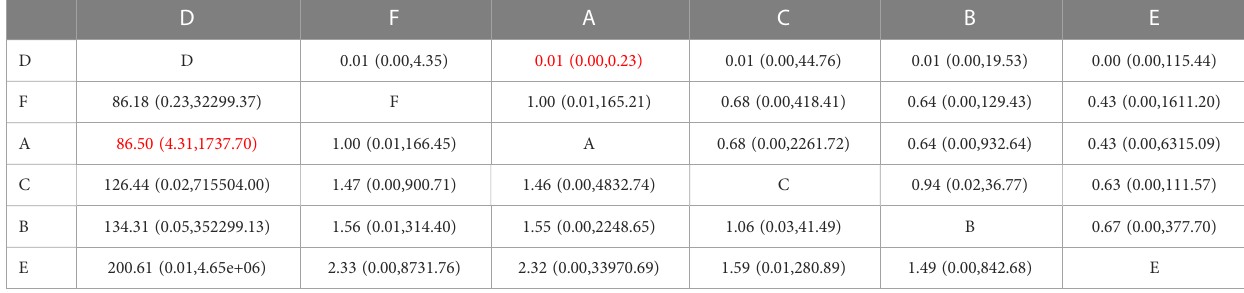
TABLE 2C Matrix of percent change in SALT scPercent change in SALT score after different JAKi treatment(shown as SMD and 95% Cls).